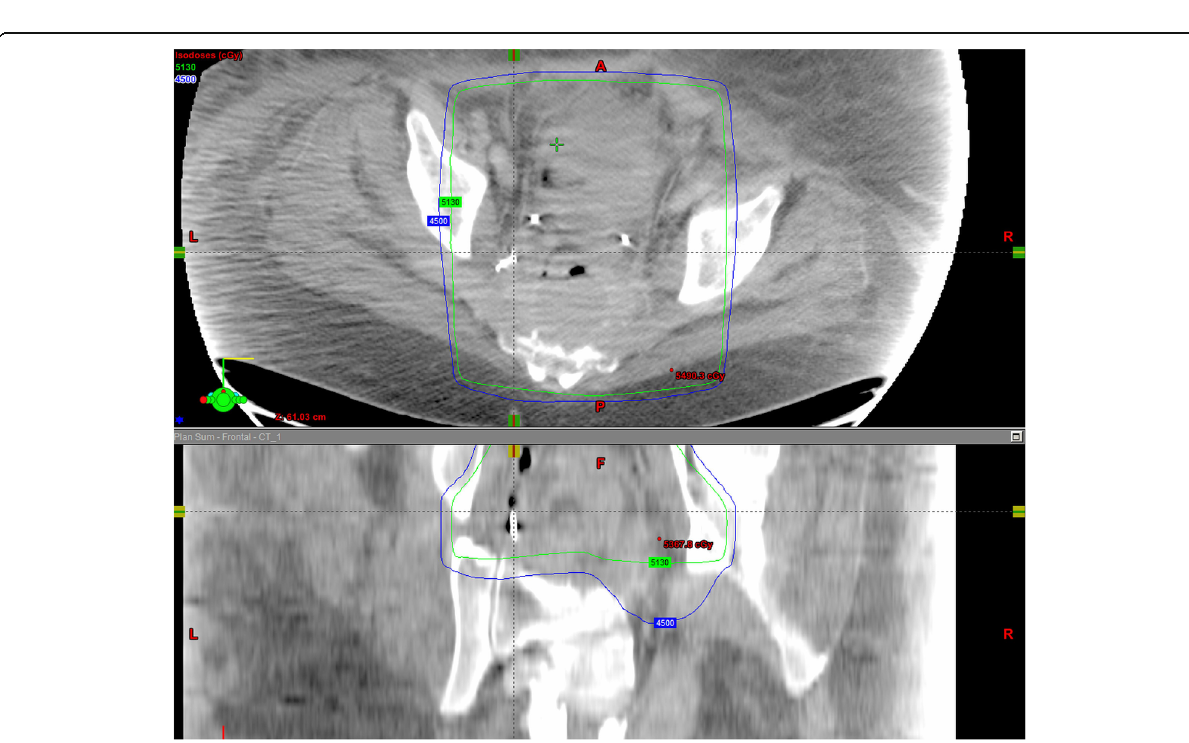
Fig. 3 Radiation dose distribution images superimposed on CT angio abdomen and pelvis following PSA embolization. The PSA is noted to be within the 95% isodose line (5130 cGy, green line). Of note bilateral ureteral stents are seen anterior to the left pelvic embolization